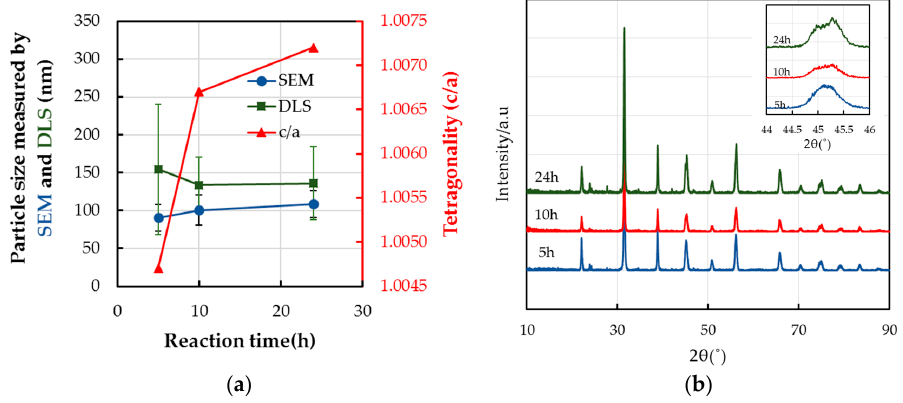
Figure 3. Variation in the ( a ) size and c/a and ( b ) XRD peaks of BT-PVP particles as a function of the reaction time (5, 10, and 24 h) at 230 °C. The inset is the XRD magnification from 44 to 45°.